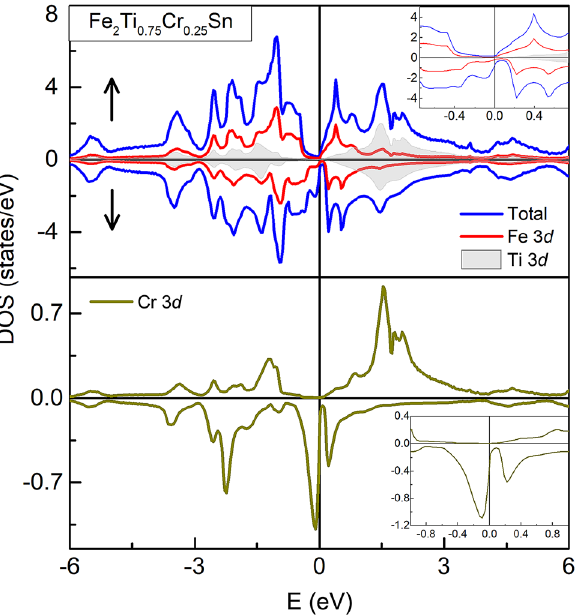
Figure 8. Spin projected total and partial DOS for Fe 2 Ti 0.75 Cr 0.25 Sn. For clarity pDOS of the Cr d state is shown in the lower